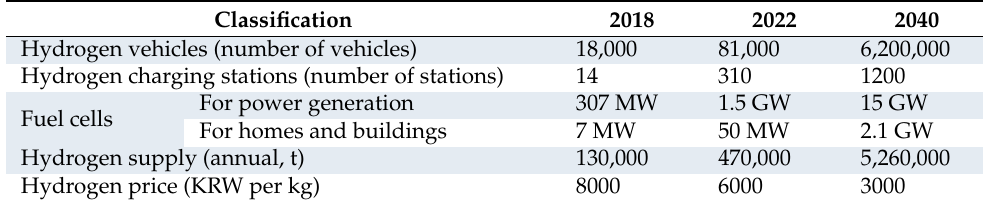
Table 1. Major roadmaps for implementing the hydrogen economy.